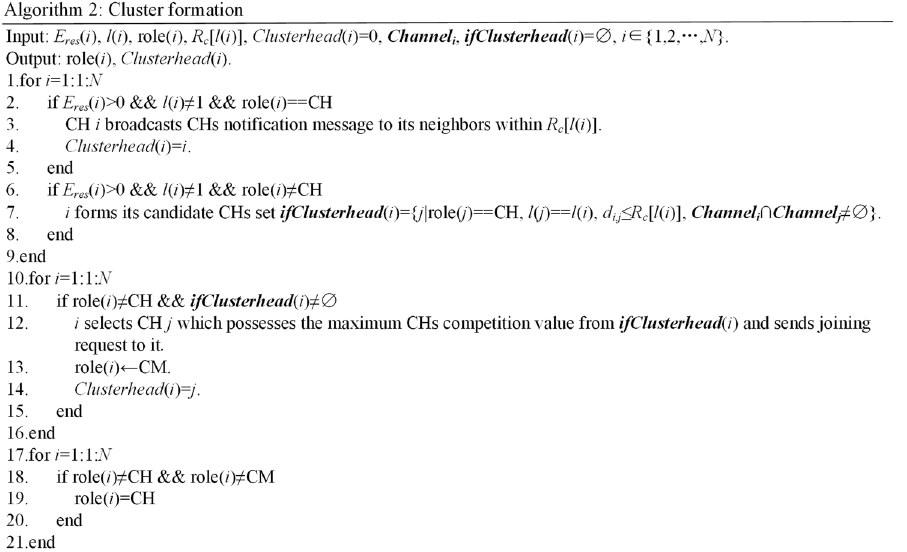
Figure 4. Pseudo code for cluster formation.